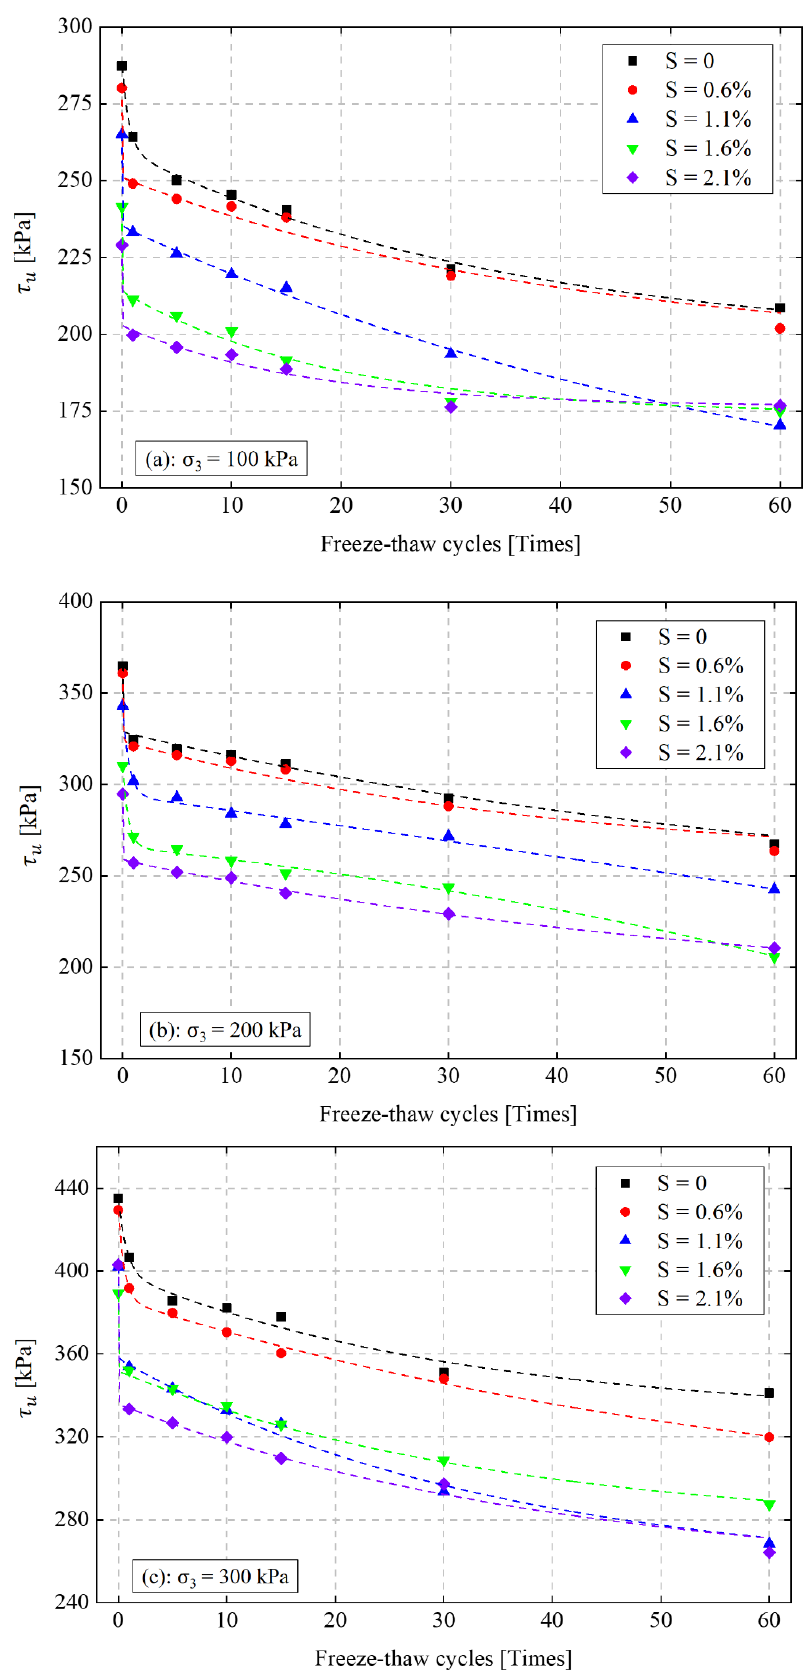
Figure 9. Shear strength versus FTCs for the specimens with different salt contents. Table 4. Equation of trendlines of shear strength versus the number of FTCs at a confining pressure of 100 kPa.